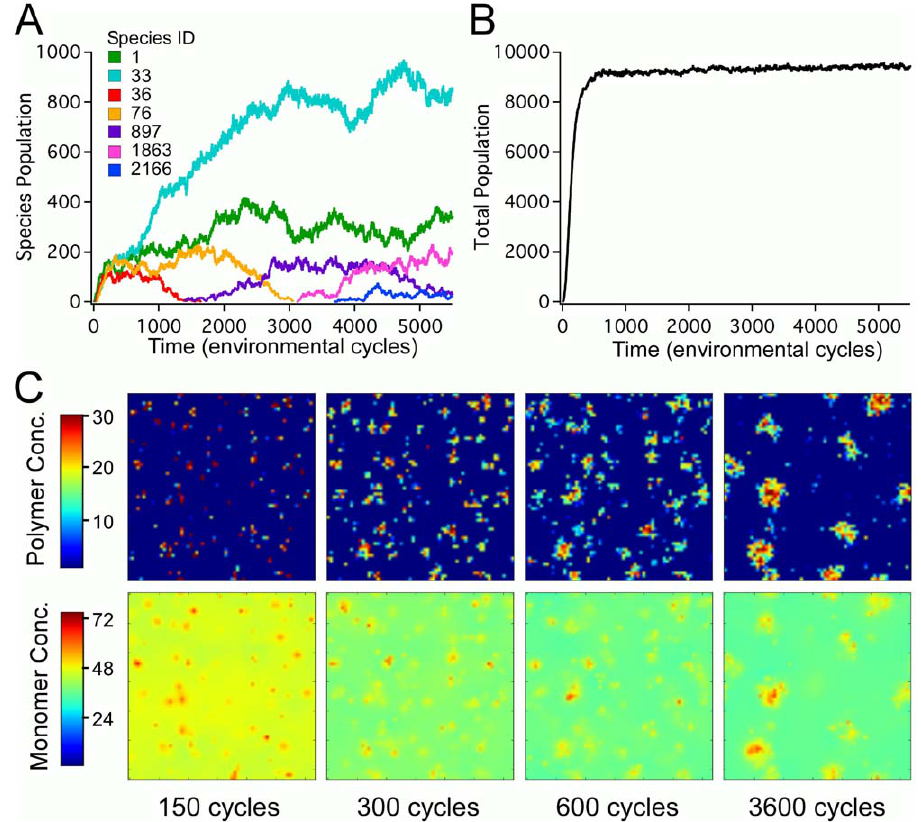
Figure 1. Sequence evolution of the polymer pool. A: Time evolution of the populations of seven specific sequences; B: Time evolution of the total polymer population; C: Spatial snapshots of the total polymer and monomer concentrations at four representative times. Species ID indicates the order of appearance of the first individual of a particular sequence in the polymer pool. The kinetic rate constants are k s ~ 10 { 7 , k r ~ 10 { 4 , and k h ~ 0 : 1 , and polymer and monomer diffusivities are set as k p ~ 0 : 001 and k m ~ 10 : 0 sites/cycle, respectively. Units of time are in number of cycles.